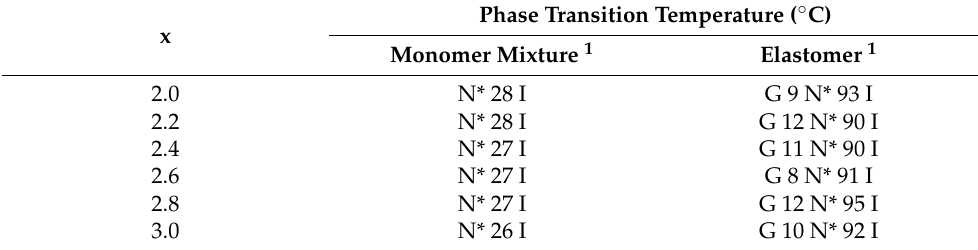
Table 2. Phase transition temperatures of N* LC ( x ) monomer mixtures and elastomers with different ISBCD